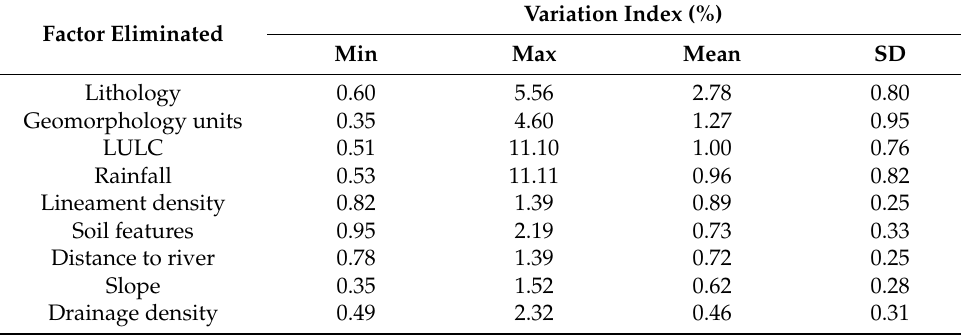
Table 8. Map elimination sensitivity analysis (one factor is eliminated at a time).